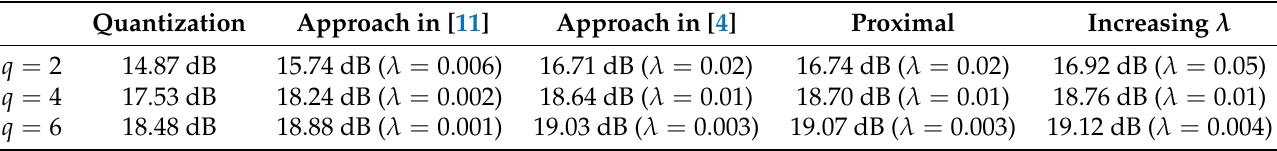
Figure 3. Demonstrationof the resulting images (where the fifth root of the intensities multiplied by 1/2 has been used to amplify the details). All the results correspond to q = 2 phase levels. Furthermore, the square regions have been magnified to better demonstrate the results. ( a ) Desired response intensity image, ( b ) non-regularized optimization followed by simple quantization to 2 phase levels, ( c ) regularized optimization using the regularizer in (6) with λ = 0.006 and ρ = 2 (as used in [11]), ( d ) regularized optimization using the regularizer in (6) with λ = 0.02 and ρ = 0.5 (as used in [4]), ( e ) regularized optimization using the regularizer in (7) with λ = 0.02 (proposed approach), and ( f ) regularized optimization using the regularizer in (7) where λ was linearly increased over 5000 iterations from 0 to 0.005. Table 1. PSNR values obtained by the various optimization approaches considered for various values for the number of discrete phase levels q . Note that for all approaches that employ regularized optimization, several experiments were conducted for various values of λ and the table gives the results that gave the best PSNR values and the corresponding value for λ